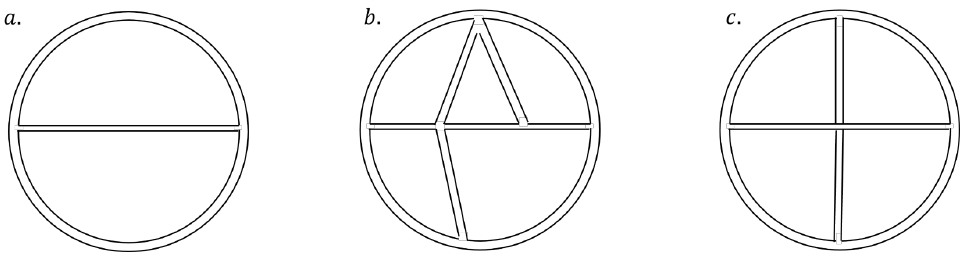
Figure 1 . Three diagrams contributing to the vacuum energy of Yang-Mills. Diagrams a and b are both planar and scale like N 2 . Diagram a has 2 vertices, 3 propagators, and 3 colour loops and so scales as N 2 N − 3 N 3 = N 2 . Diagram b has 6 vertices, 10 propagators, and 6 colour loops resulting again in N 6 N − 10 N 6 = N 2 scaling. In contrast, diagram c is non-planar: it has 4 vertices, 6 propagators, and 2 colour loops, resulting in N 4 N − 6 N 2 = N 0 and so is suppressed in the large N